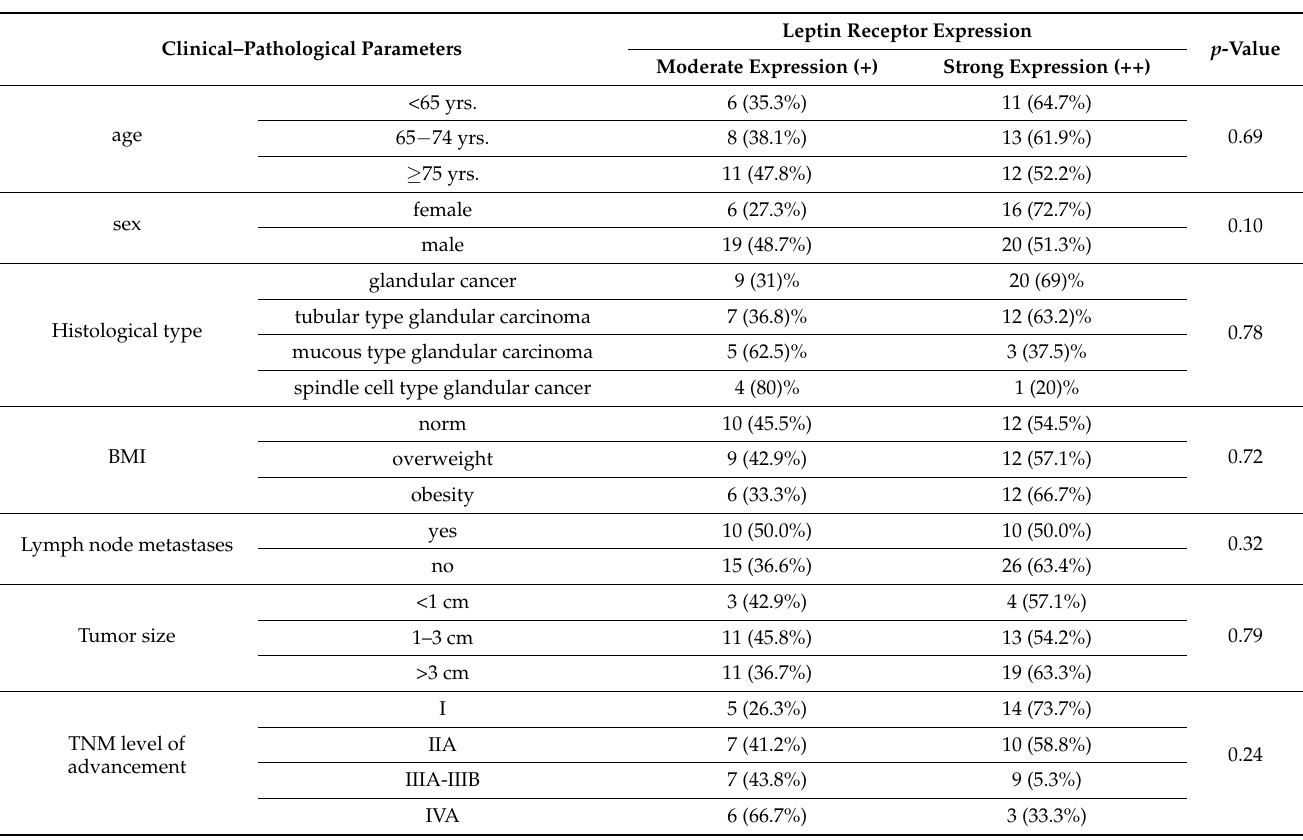
Table 1. Influence of clinical-pathological factors on leptin receptor